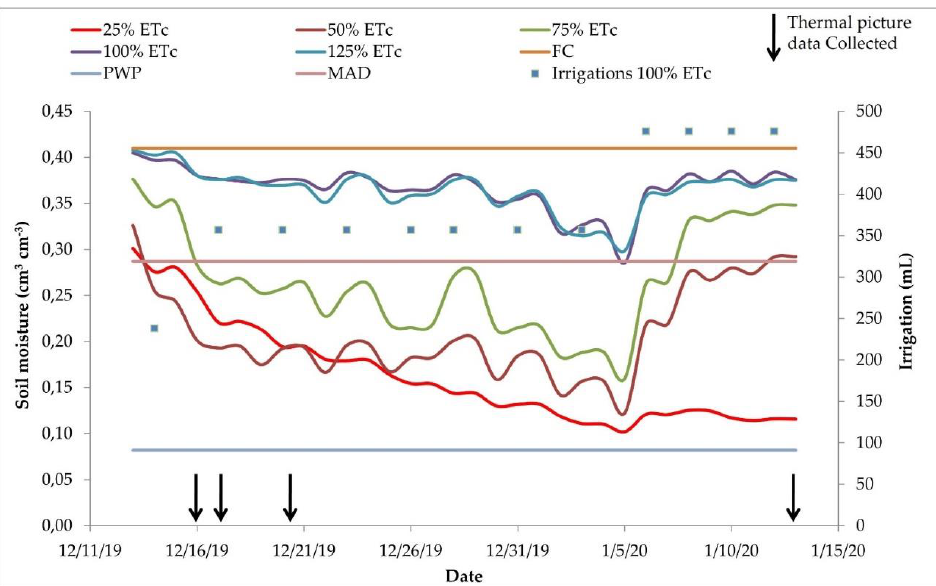
Figure 7. Substrate moisture and amount of irrigation applied during the study. Each colored line indicates the average values of three sensors. The upper reference line indicates the field capacity (FC), the lower line represents the permanent wilting point (PWP), and the central line represents the maximum allowed depletion (MAD). Irrigations 100% show the water volumes applied to the treatment 100%. The black arrows indicate the days in which the thermal images were taken. ETc = crop evapo- transpiration.